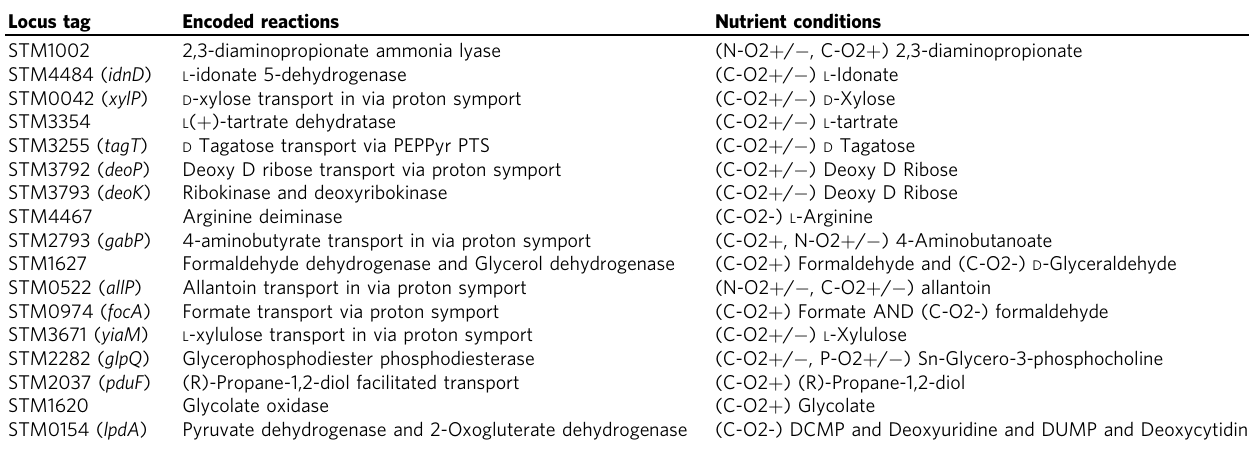
Table. 1 Conditionally essential genes observed to affect fi tness in cattle, chicken, and pig but not mouse spleen, and their calculated TRADIS fi tness score Locus tag Encoded reactions